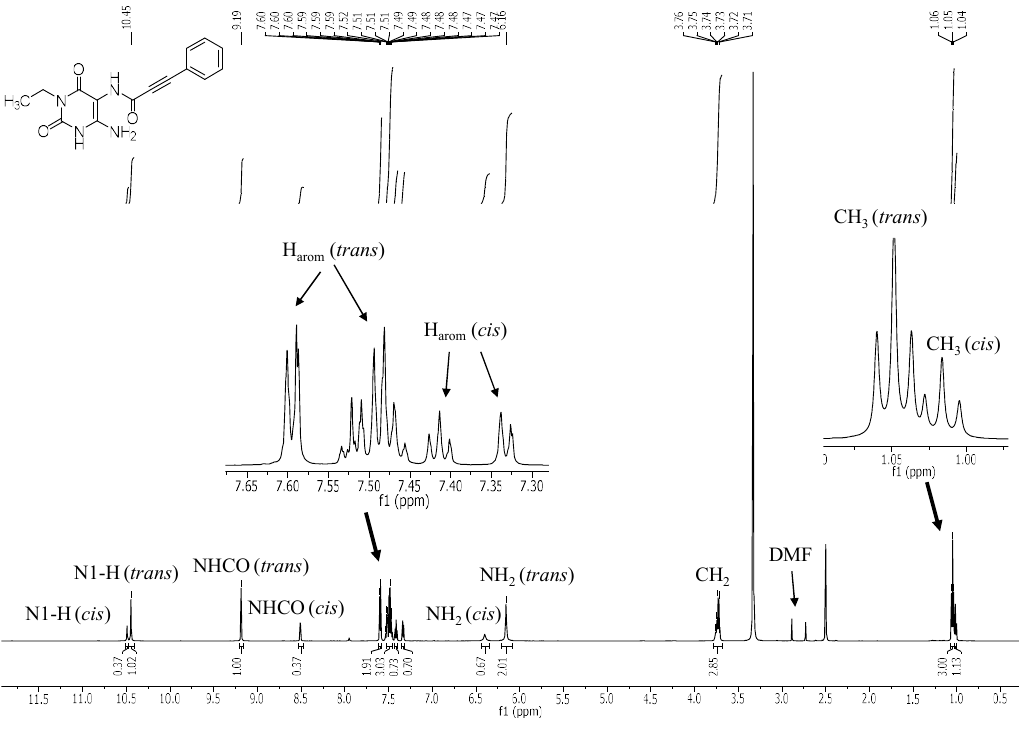
Figure 2. 1 H-NMR spectra of compound 8a in DMSO- d 6 .